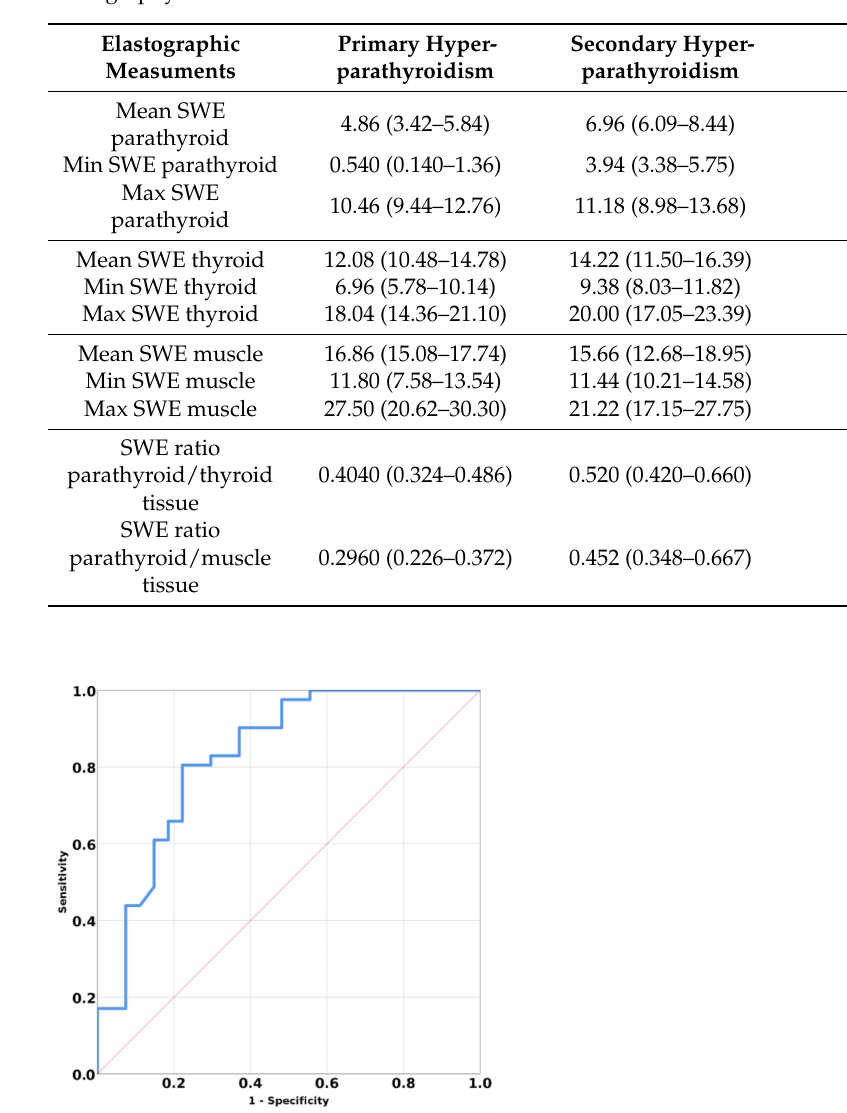
Table 5. Elastography results in primary vs. secondary hyperparathyroidism. SWE: shear wave elastography.